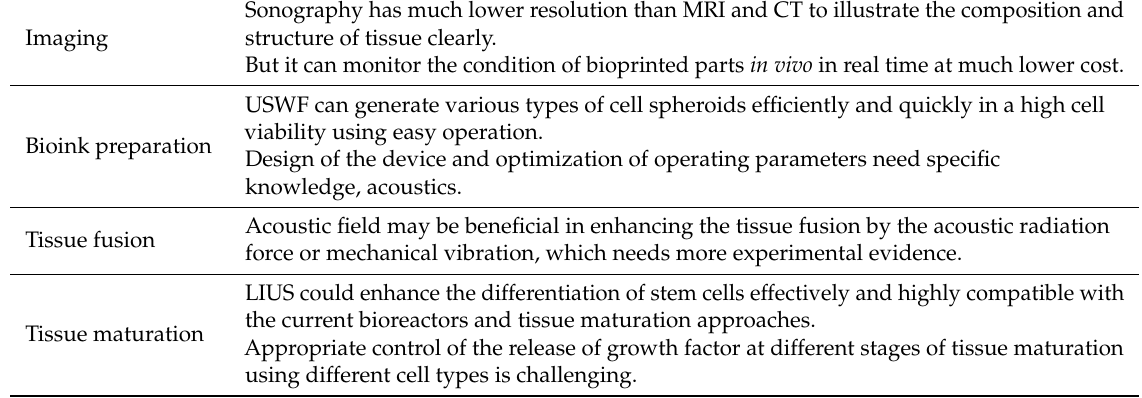
Table 2. Summary of the potential of ultrasound in 3D